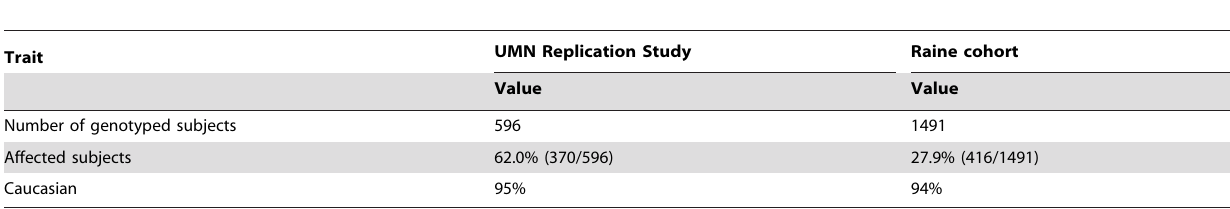
Table 1. Participant characteristics for the University of Minnesota (UMN) family-based study population and the Western Australian Raine longitudinal birth